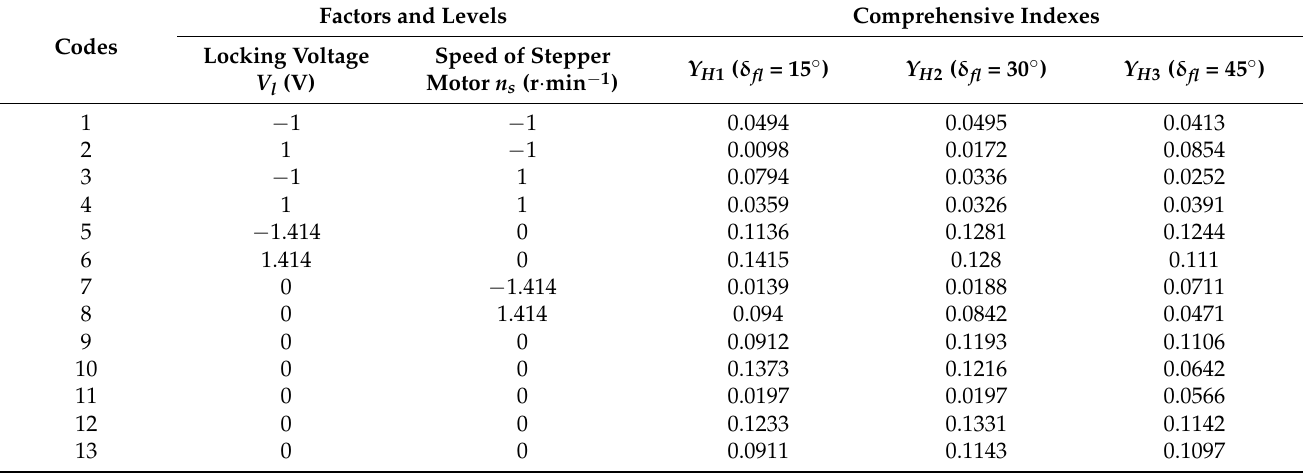
Table 2. Binary quadratic rotation combination test design, and results for the four-wheel-steering MMS.